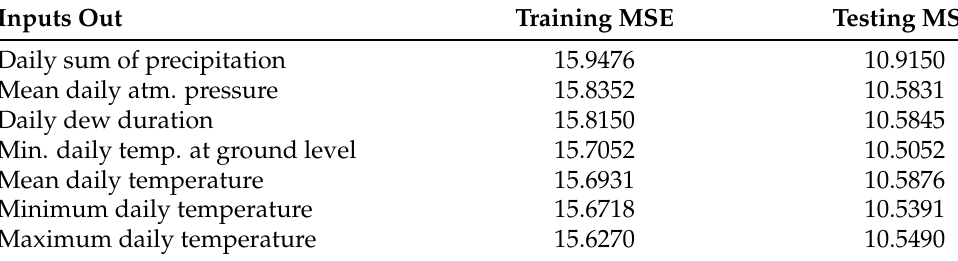
Table A15. The results of the sensitivity analysis for the prediction of the daily sum of precipitation.